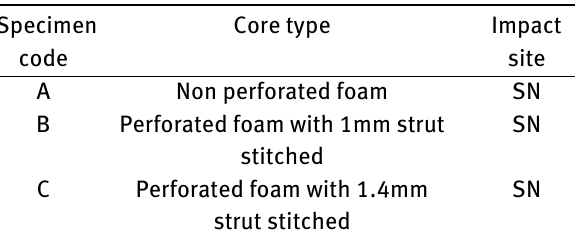
Table 3: Specifications of the sandwich composite specimens used in the study.